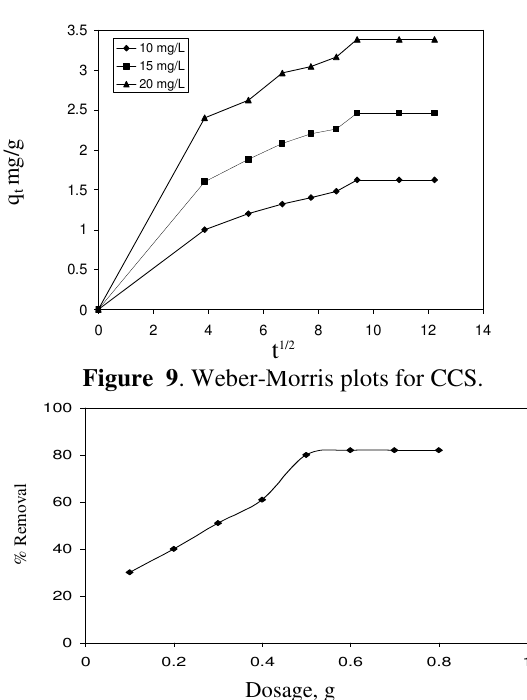
Figure 10. Influence of adsorbent dose on percent removal of fluoride on